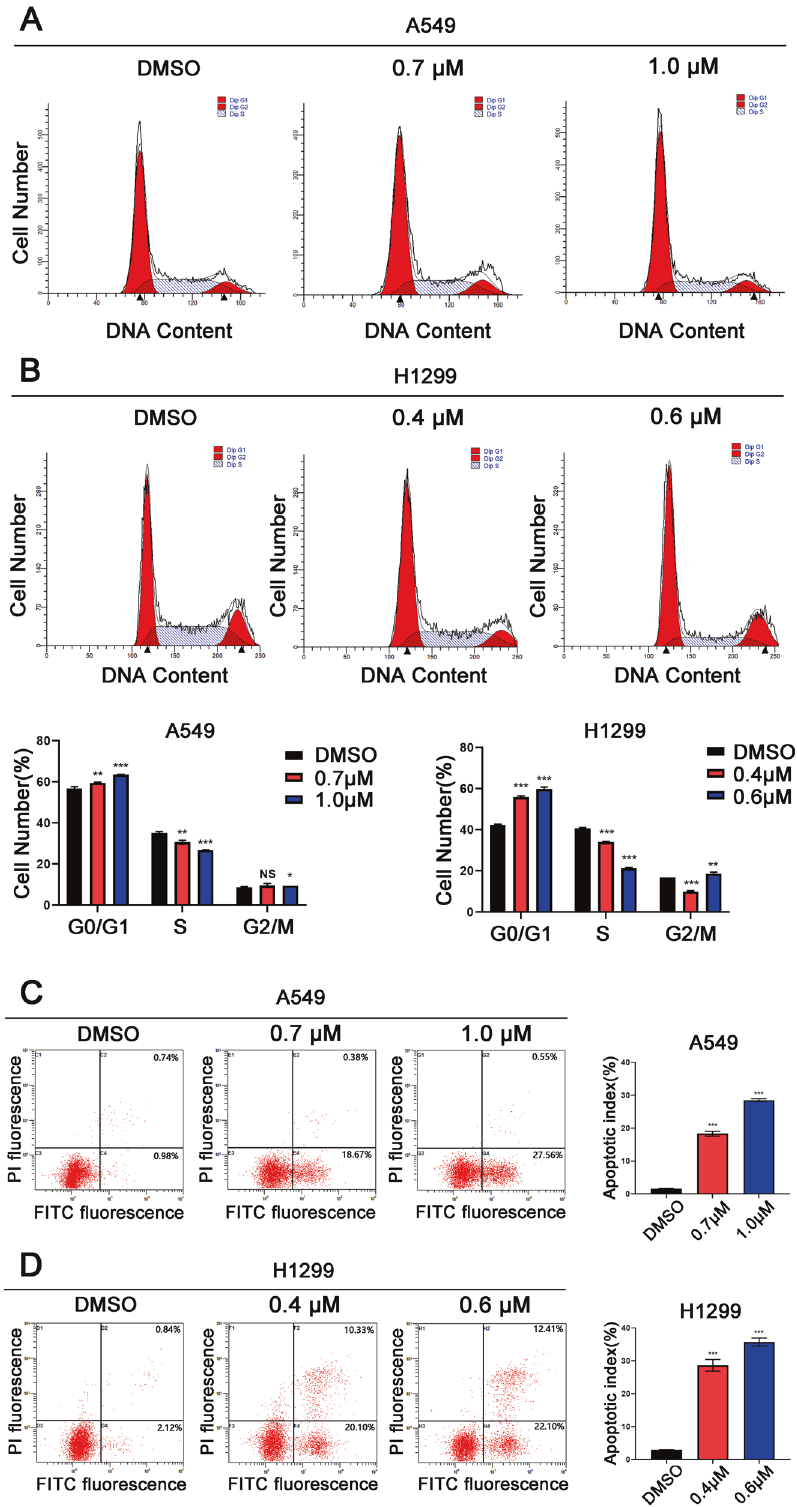
Fig. 2 ALCAP2 arrests the cell cycle and promotes the apoptosis of LUAD cells. A , B Flow cytometry assay of LUAD cell lines. The cells were harvested at 24 h after treatment with or without ALCAP2 and stained with PI. The percentage of cells in each cell cycle phase is shown in the inset of each panel. C , D Flow cytometry assay of A549 and H1299 cells treated with or without ALCAP2. Cells harvested at 24 h after transfection and stained with Annexin V-FITC and PI. The right histogram panel shows the statistics of the number of apoptotic cells in each group. The data were presented as the mean ± SD of three measurements. NS: no signi fi cance, * P < 0.05; ** P < 0.01; *** P < 0.001.